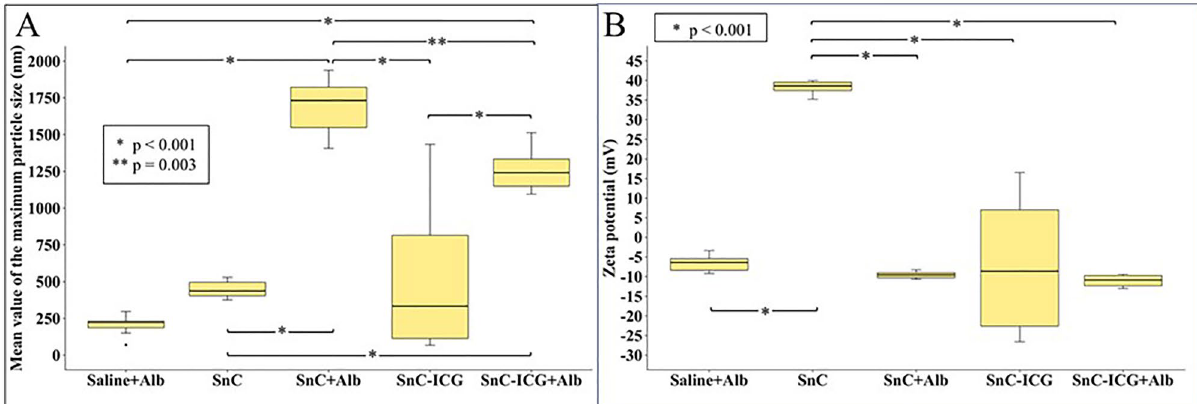
Figure 6. Particle size and zeta potential distributions of the tested samples. A, distribution of mean particle sizes estimated from scattering distribution intensity; B, distribution of peak zeta potentials. Saline + Alb, albumin added saline; SnC, stannous colloid; SnC + Alb, albumin added SnC; SnC–ICG, stannous colloid/ICG mixed tracer; SnC–ICG + Alb, albumin added